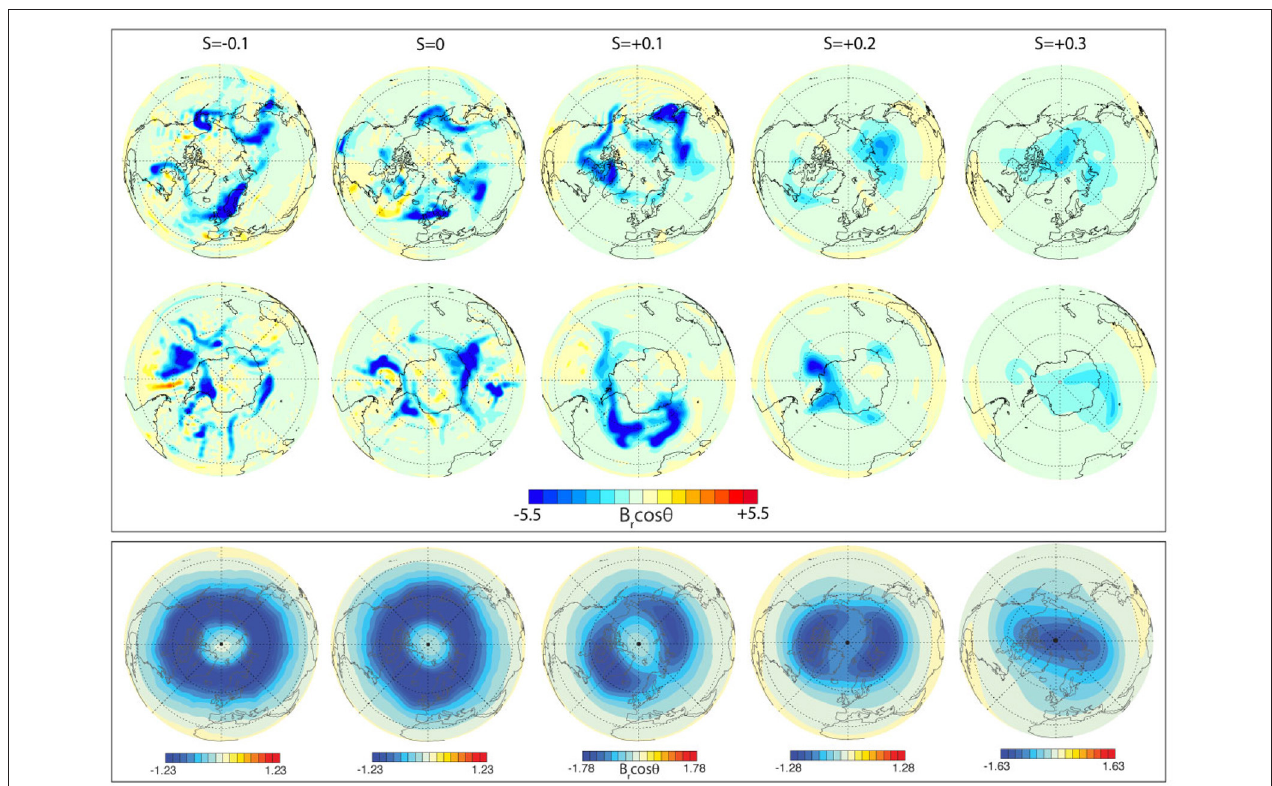
FIGURE 5 | Snapshots and time averages of B r cos( θ ) from numerical dynamos at Ra hemisphere snapshots; middle row: Southern hemisphere snapshots at the same times; bottom row: Northern hemisphere time averages. Magnetic field intensities are in dimensionless Elsasser number